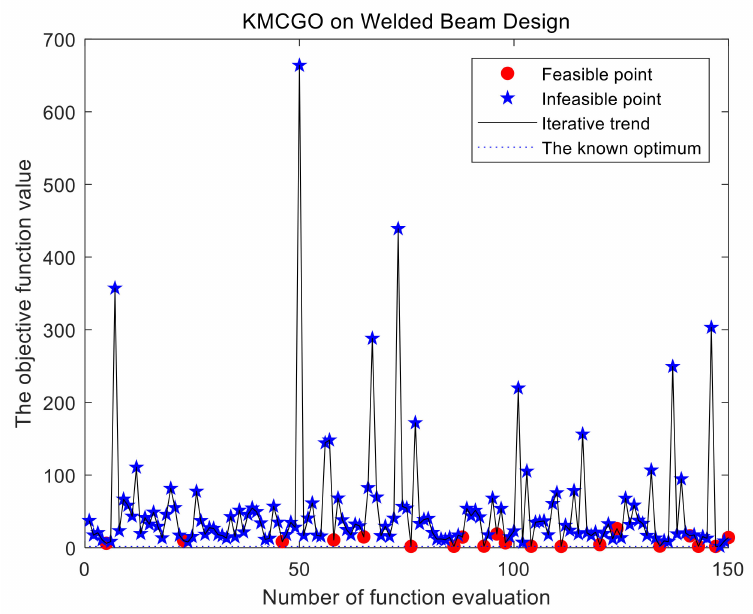
Figure 8. Iteration result of the WBD problem.